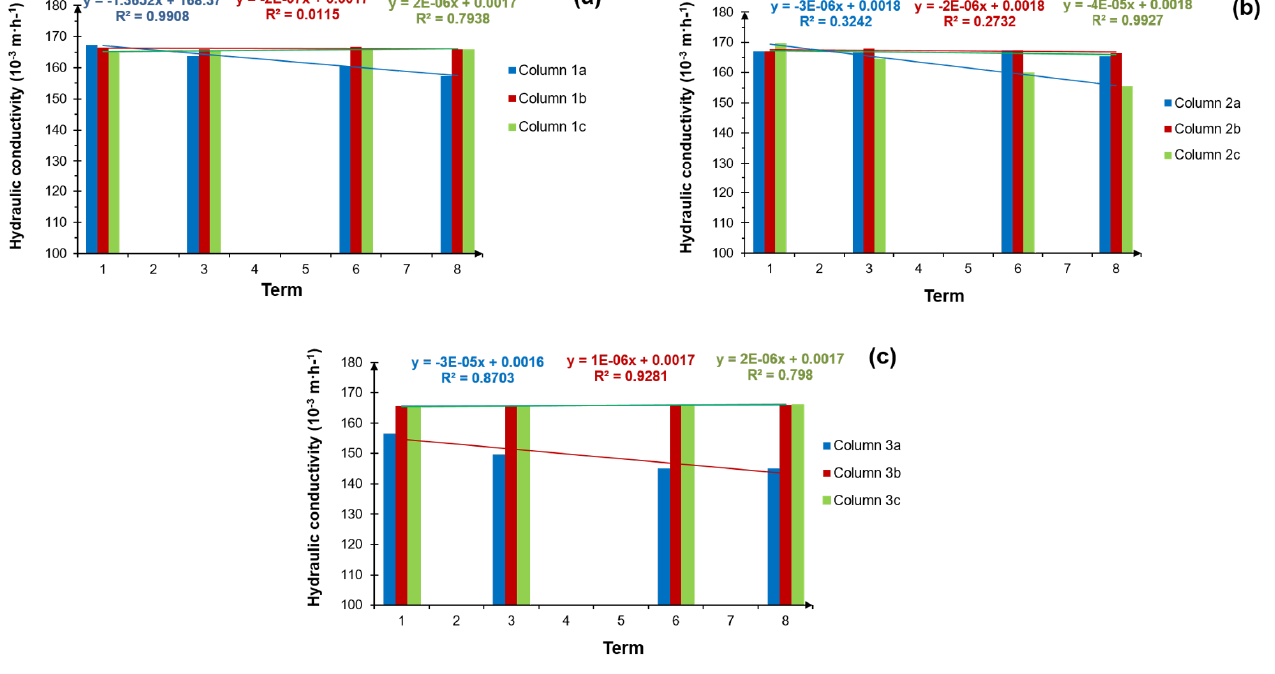
Figure 14. Hydraulic conductivity for: ( a ) column group 1, supplied with treated wastewater, ( b ) column group 2, supplied with treated wastewater and brine solution periodically, and ( c ) column group 3, supplied with tap water; terms from 1 – 8 represent the measurement periods after 1 – 8 regenerations.